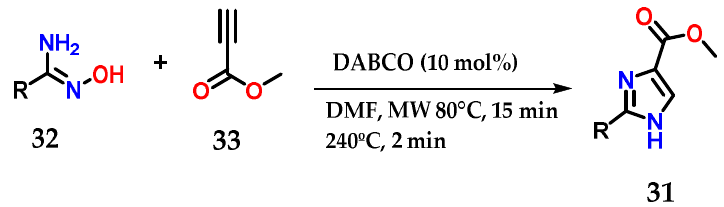
Figure 15. Disubstituted imidazoles 31 were obtained from the base-catalyzed condensation of amidoximes 32 and methyl propiolate 33 .